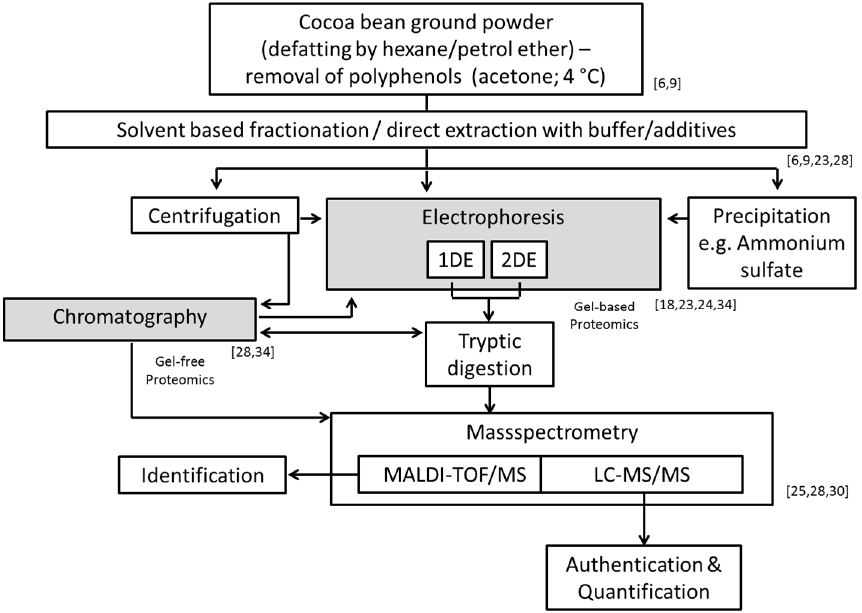
Figure 2. Compilation of the methods and characterization options applied for cocoa bean proteins denoted with corresponding relevant studies [6,9,18,23–25,28,30,34].